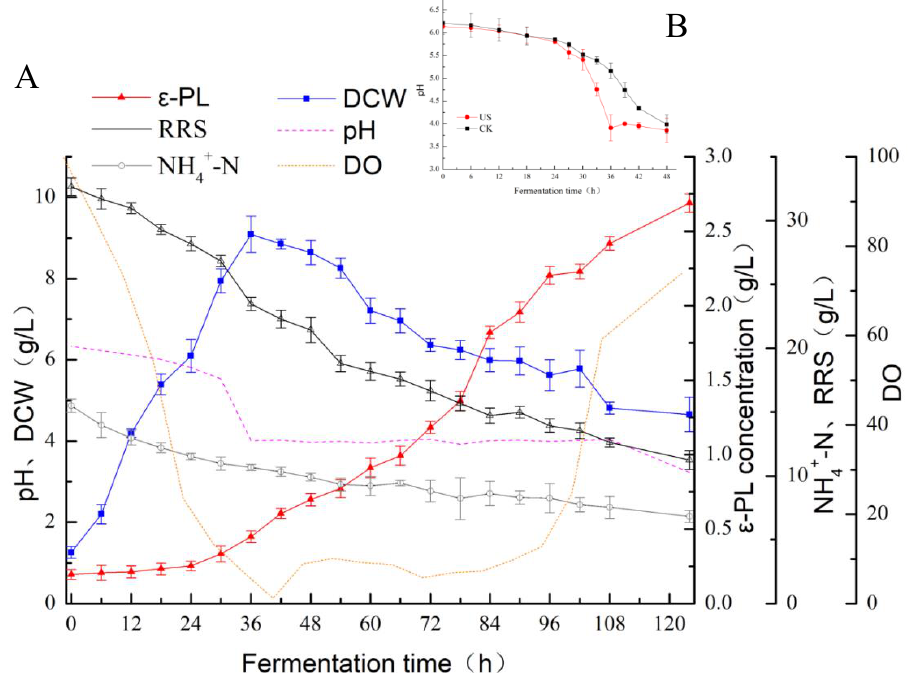
Figure 2. Ultrasound-assisted fermentation on SAR 14-116 production of ε -polylysine levels. ( A ) Time profiles of cell growth (DCW), ε -PL concentration ( ε -PL), residual reduced sugar (RRS), ammonia nitrogen (NH 4+ -N) and dissolved oxygen (DO) under ultrasound-treated cultivation of S. albulus SAR 14-116; ( B ) Changes of pH between sonication treatment and non-sonication treatment.